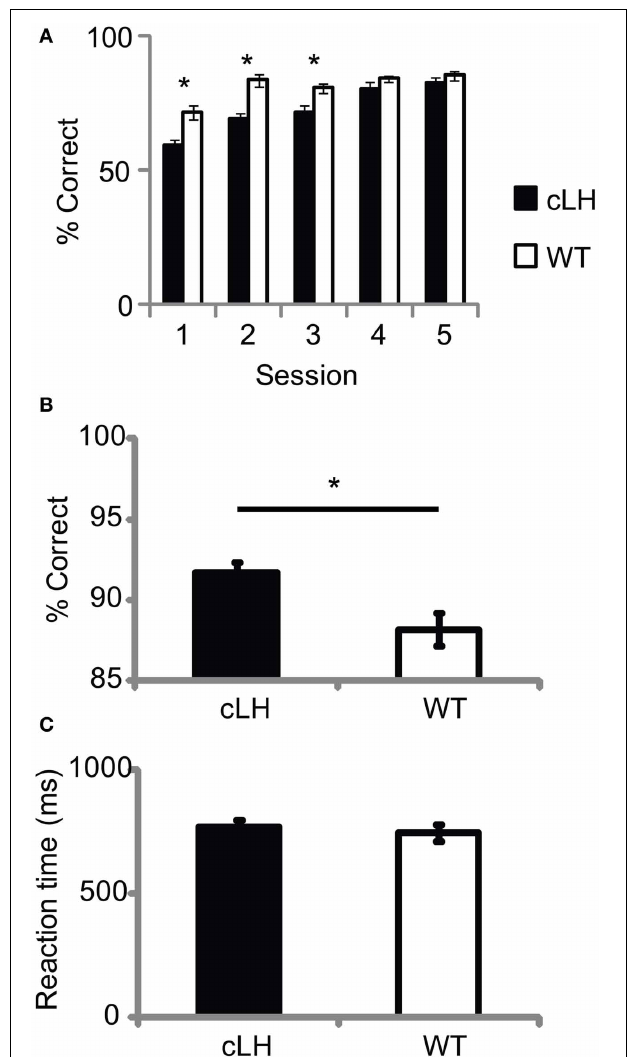
FIGURE 3 | Pavlovian conditioning and forced-choice accuracy. (A) Slower Pavlovian conditioning in cLH rats. (B) cLH rats responded more accurately during forced-choice trials with even, constant reward sizes on both sides. (C) Reaction time from lever press to sucrose delivery port during same forced-choice trials as in (B) . ∗ P < 0 . 01. Student’s t -test on individual sessions in (A) . Error bars indicate